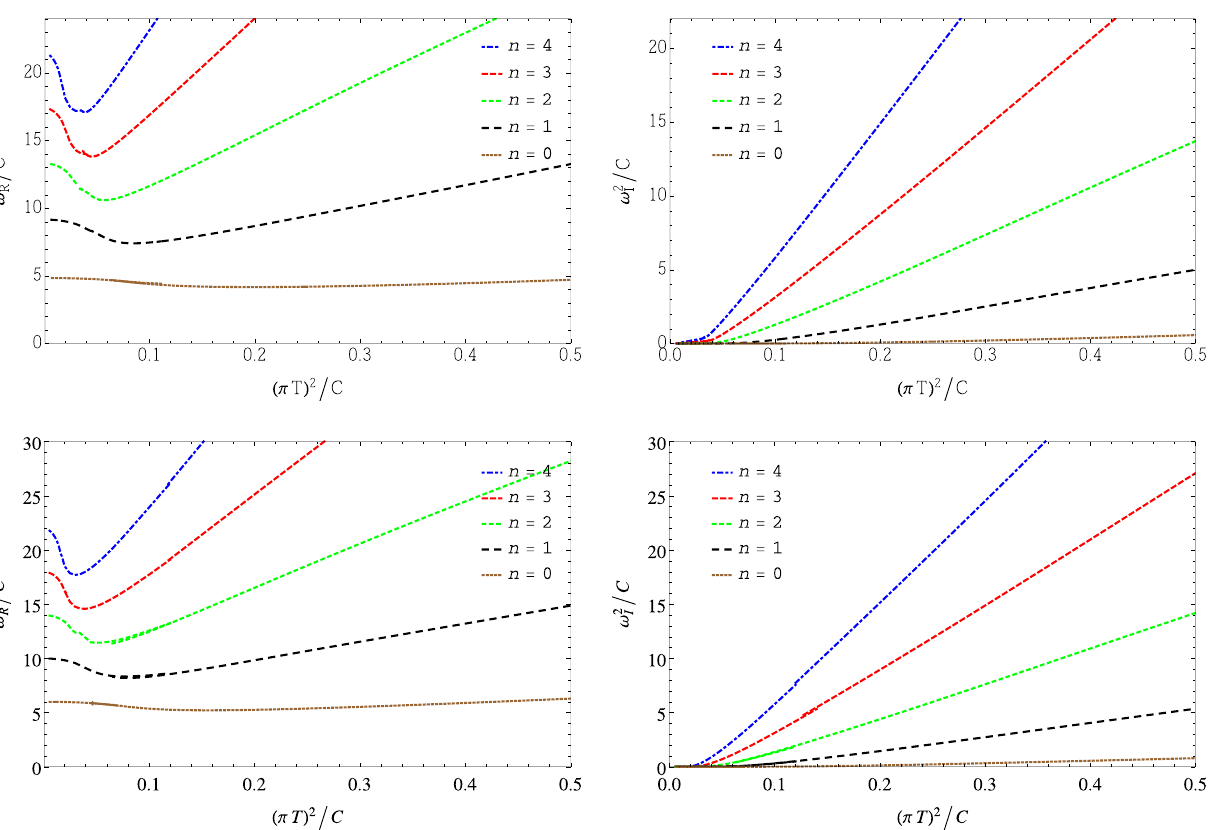
Fig. 9 The first five QN frequencies obtained using the Breit-Wigner, power series, and pseudo-spectral methods. The top panels show the results obtained for G = 1, while the bottom panels show the results for G = 50